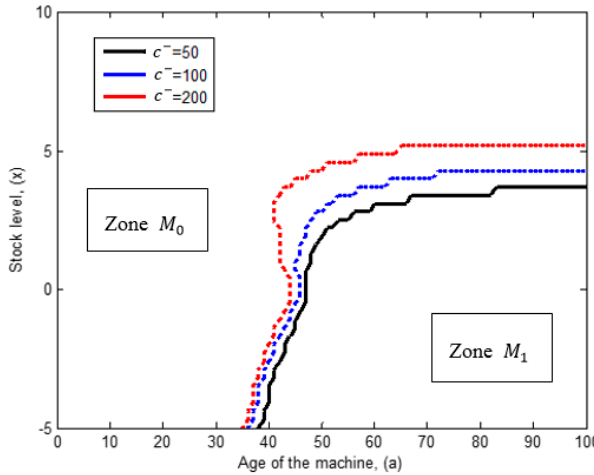
Figure 8. Sensitivity of the backlog cost on the repair/major maintenance policy.